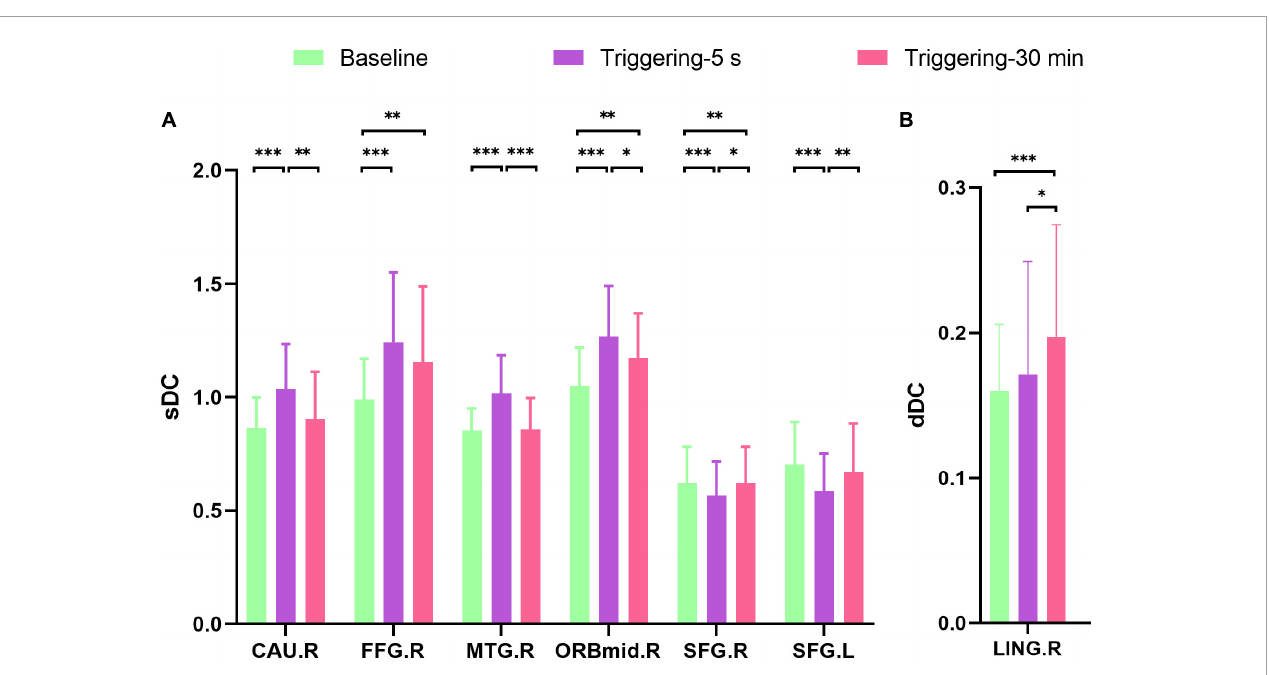
FIGURE3 Post hoc comparisons of analysis of variance. The connection between two bars represents significant between-time differences of sDC (A) and dDC (B) ( ∗ represents significant level P < 0.05, ∗∗ denotes significant level P < 0.01, and ∗∗∗ indicates significant level P < 0.001, Bonferroni correction). sDC, static degree centrality; dDC, dynamic degree centrality; baseline, the rs-fMRI was performed before stimulating the trigger zone; triggering-5 s, the rs-fMRI was performed within 5 s after stimulating the trigger zone; triggering-30 min, the rs-fMRI was performed at the 30th minute after stimulating the trigger zone. CAU.R, right caudate nucleus; FFG.R, right fusiform gyrus; MTG.R, right middle temporal gyrus; ORBmid.R, right middle frontal gyrus, orbital part; SFG.R, right superior frontal gyrus; SFG.L, left superior frontal gyrus; LING.R, right